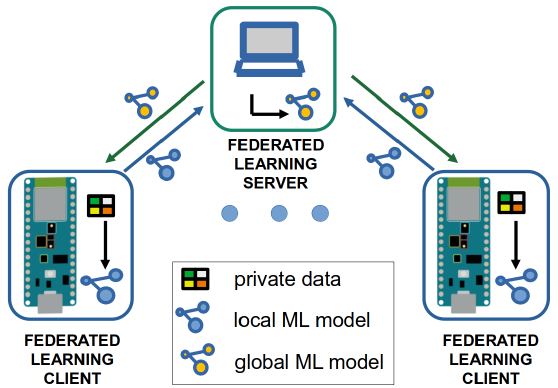
Figure 3. Implemented federated learning components and their